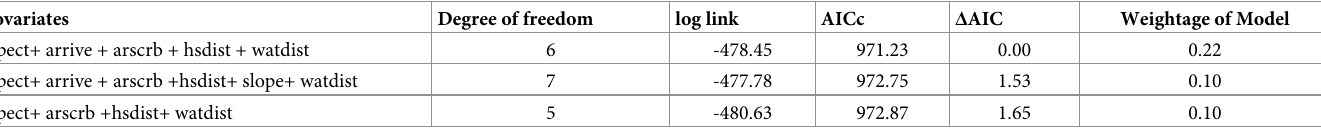
Table 2. Result of Generalised Linear Model used to evaluate the environmental and anthropogenic variables on-site use by striped hyena in the human-dominated landscape of Sawai Mansingh wildlife sanctuary, Rajasthan. Top candidate models predicting the habitat selection of striped hyaena in the landscape in Sawai Mansingh Wildlife Sanctuary, Rajasthan, India; aspect; area of riverine (arrive); area of scrubland (arscrb); slope; distance from the human settlement (hsdist); distance from water (watdist); area of forest cover (arfcm); human RAI (human).